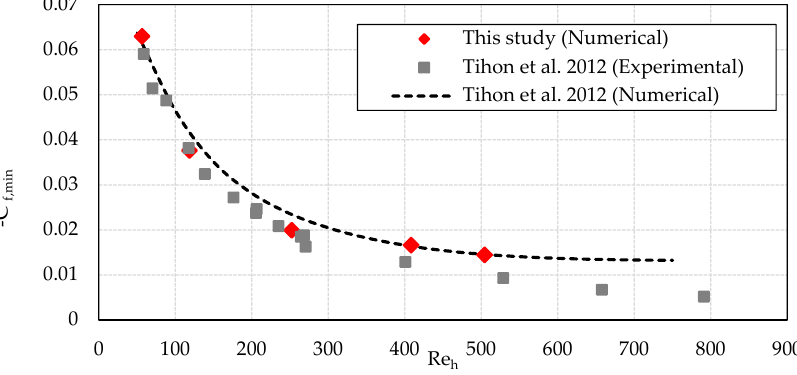
Figure 7. Dimensionless u-velocity profiles (u/U max ) at Re h = 672. ( a ) x/h = 5, ( b ) x/h = 7.5, ( c ) x/h = 12, ( d ) x/h = 15, ( e ) x/h = 22.5, ( f ) x/h = 30 [23]. The locations were chosen at different locations, including recirculation zones at the upper and bottom walls. The u-velocity profiles showed that the flow separated at the